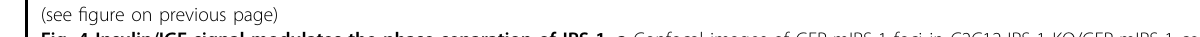
Fig. 4 Insulin/IGF signal modulates the phase separation of IRS-1. a Confocal images of GFP-mIRS-1 foci in C2C12-IRS-1 KO/GFP-mIRS-1 cells treated with control or with IGF-1-conditioned (100ng/mL) medium for 2.5 min. Scale bar, 10 µm. Quantitative analysis of number of mIRS-1 puncta is shown with results presented as violin plots. *** p < 0.001. b FLAG-tagged and GFP-tagged mIRS-1 were co-transfected into 293 T cells. Cells were serum starved for 16 h followed by IGF-1 stimulation and coimmunoprecipitation analysis. c Immuno fl uorescence staining of endogenous p-IRS-1 (Y608) antibody in C2C12-IRS-1 KO/GFP-mIRS-1 cells treated for 5 min with control medium or IGF-1-conditioned medium. Scale bar, 5 µm. Line scan showing the related intensity pro fi les of mIRS-1 with p-IRS-1 (Y608). The puncta diameter was quanti fi ed ( n = 69). Data in the bar graphs represent the means ± SEM. d Immunoblot analysis of Y608 residue tyrosine phosphorylation of FLAG-mIRS-1 puri fi ed from starved or insulin-stimulated (15 min) 293 T cells. Quanti fi cation result is shown as means ± SEM. ** p < 0.001. e DIC images of FLAG-mIRS-1 puri fi ed from starved or insulin- stimulated (15 min) 293 T cells. The proteins (1 μ M) were incubated with phase separation buffer at room temperature for 20 min. Scale bar, 20 µm. Quanti fi cation result is shown as means ± SD. ** p < 0.01. f Scheme indicating the location of the nine tyrosine residues of YXXM motifs in mIRS-1. g The nine tyrosine residues of the YXXM motifs in mIRS-1 were replaced by alanine residues. h Immunoblot analysis of the IRS-1 expression levels in C2C12 wildtype, C2C12-IRS-1 KO/GFP-mIRS-1, and C2C12-IRS-1 KO/GFP-mIRS-1 9YA cell lines. i Confocal images of GFP-tagged mIRS-1 or 9YA mutant in C2C12-IRS-1 KO/GFP-mIRS-1 or C2C12-IRS-1 KO/GFP-mIRS-1 9YA cell lines. Scale bar, 10 µm. Quanti fi cation results of GFP-mIRS-1 or 9YA puncta are shown and presented as violin plots. **** p < 0.0001. j DIC images of FLAG-mIRS-1 or FLAG-mIRS-1 9YA puri fi ed from 293 T cells. The proteins (1 μ M) were incubated with phase separation buffer at room temperature for 20 min. Scale bar, 20 µm. k Phase diagrams of mIRS-1 wildtype, Δ SAR, and 9YA mutant proteins puri fi ed from insulin-stimulated cell lines in 50 mM Tris (pH 7.5), 2% (w/v) PEG-8000, and sodium chloride (ranging from 50 – 1200